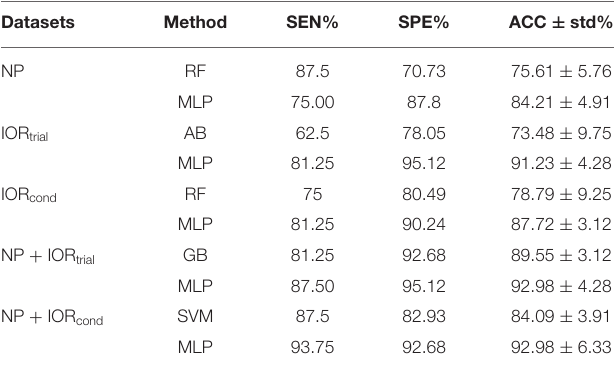
TABLE 3 | A direct comparison between the best traditional machine learning and deep learning methods (a summary of Table 2 , Supplementary Tables 1-3 ).